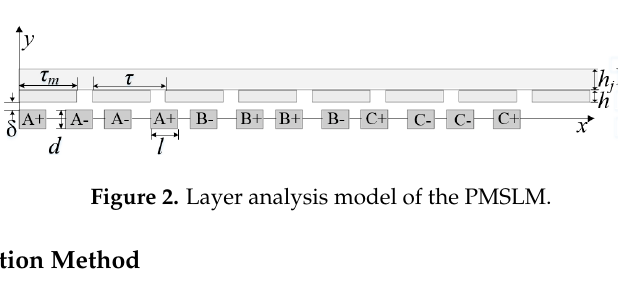
Figure 2. Layer analysis model of the PMSLM.